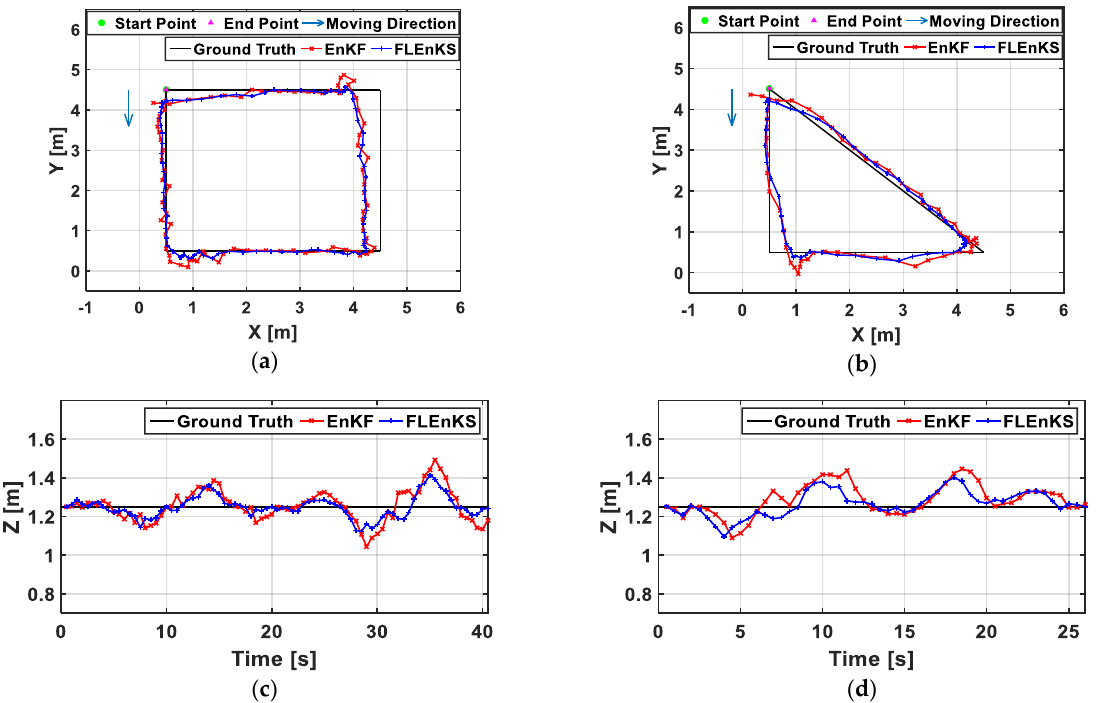
Figure 7. The estimated trajectories based on FLEnKS and Ensemble Kalman Filter (EnKF). ( a ) Rectangle trajectory, ( b ) Triangle trajectory, ( c ) Rectangle Z-axis results, and ( d ) Triangle Z-axis results. Table 3. Positioning Errors of EnKF and FLEnKS.